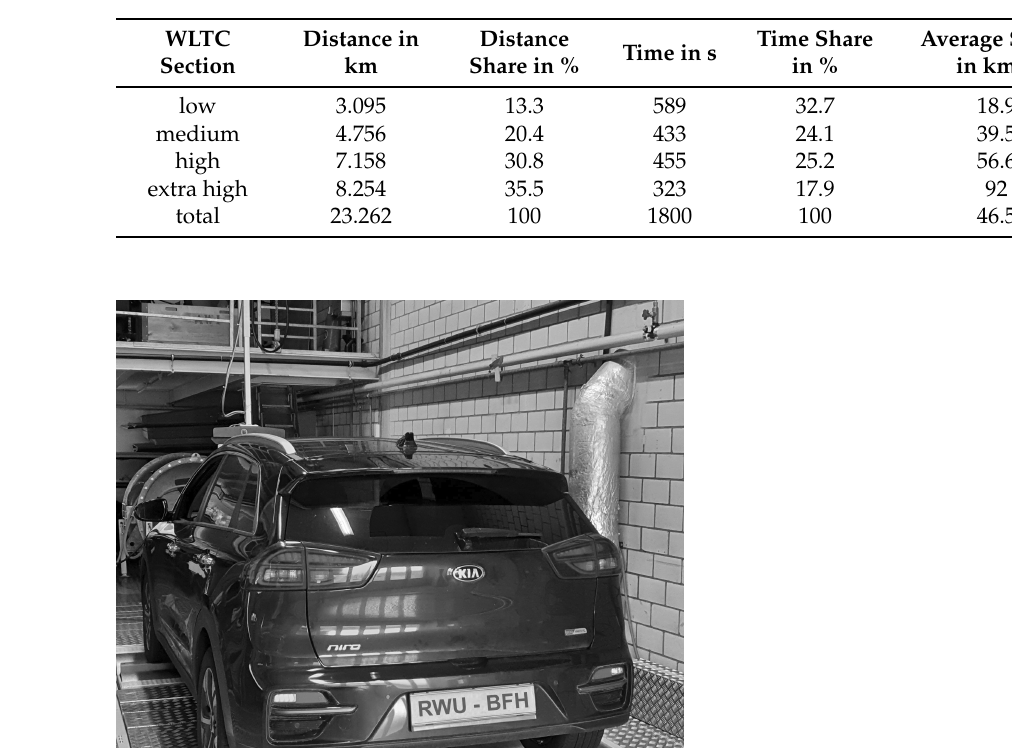
Table 1. Travelled distance, average speed and time period in the WLTC sections.